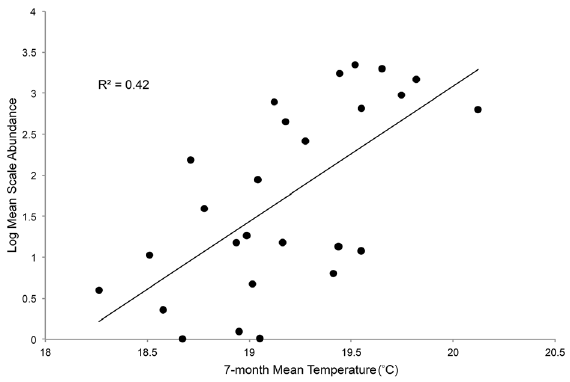
Figure 2. Linear regression of seven-month mean temperature and log mean scale abundance per 0.6 m of maple twig (log(y)= 2 29.95 + 1.65x). Regression model is statistically significant (P , 0.05).